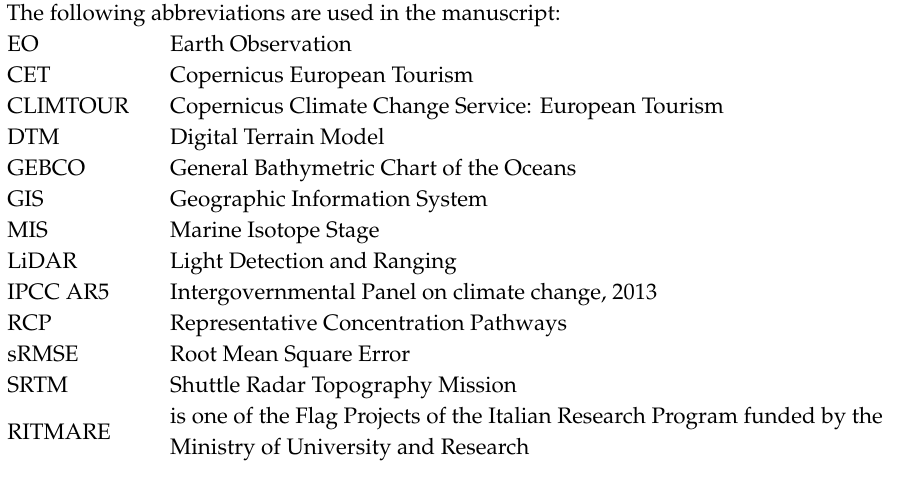
Figure S1: Eight maps of possible submerging coastal areas in the Mediterranean Sea, Video S1: Short drone flight on some coastal plains in Italy (mp4 short